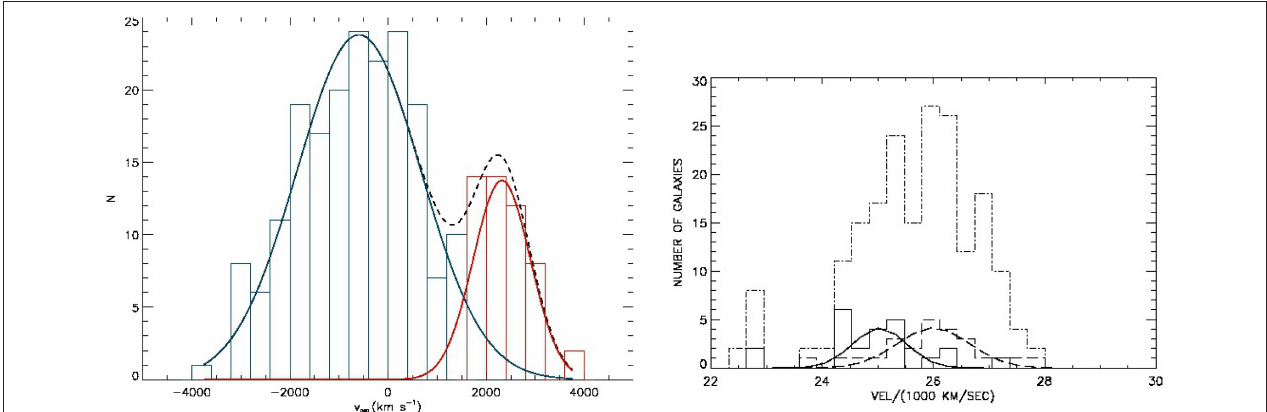
FIGURE 4 | The distribution of number of galaxies as a function of LOS velocity in two merging clusters of galaxies. Left panel: Distribution of galaxies for two partitions in A2744 are shown in green and red lines; dashed line represents the sum of the two Gaussians (from Owers et al., 2011). Right panel: Dash-dotted line shows all galaxies in the area of A1750. Number distribution of galaxies around the two centers of the merging cluster are shown with solid and dashed lines (from Molnar et al., 2013b).